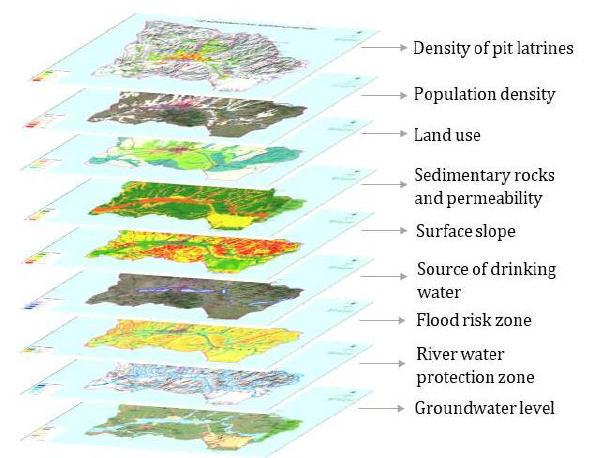
Figure 4. Multi-criteria of the